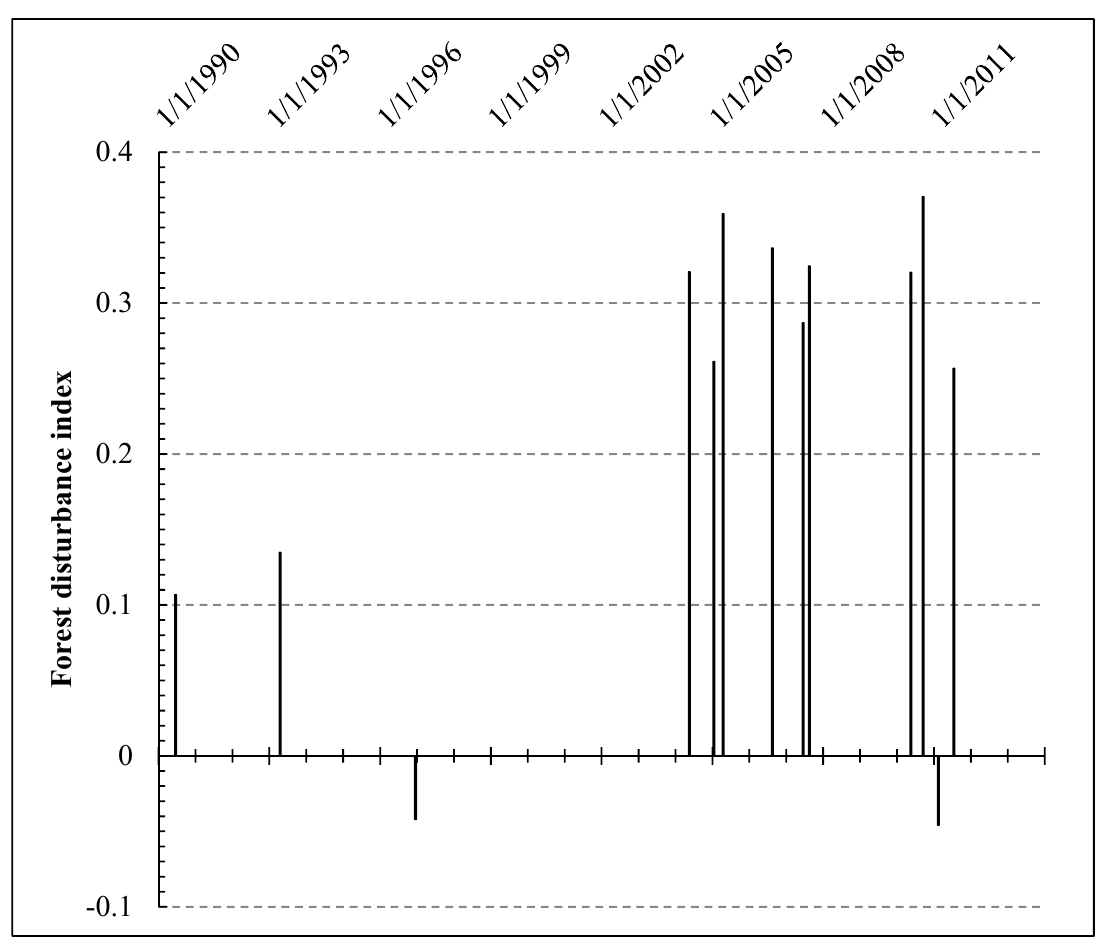
Figure 12. Temporal dynamics of forest disturbance (DI). Negative DI means no disturbance and optimal forest growth, and positive values mean forest disturbance due to windfalls, logging or other abiotic stress. Mean DI value calculated over the BNR was negative in 1996 and positive for the rest of the sampling years. An increase in frequency and magnitude of the positive values since 2004 indicates significant forest